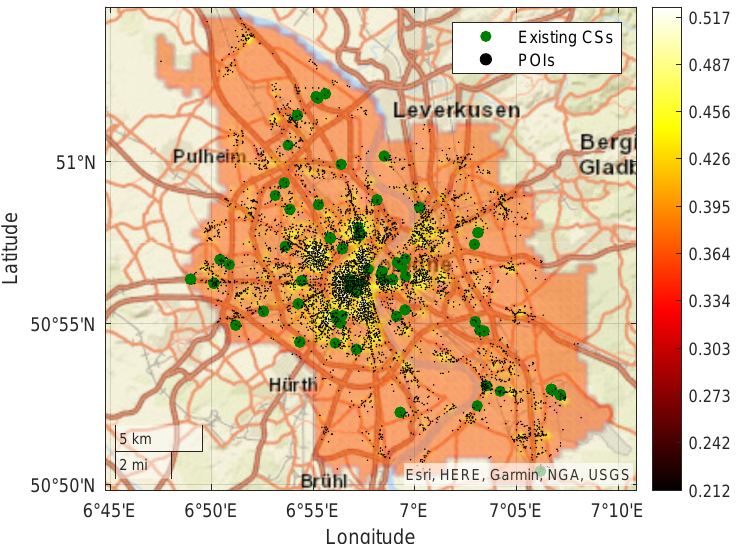
Figure 5. Heat map of Cologne depicting attractiveness calculated based on POIs, where yellow indicates a high attractivness and red a low